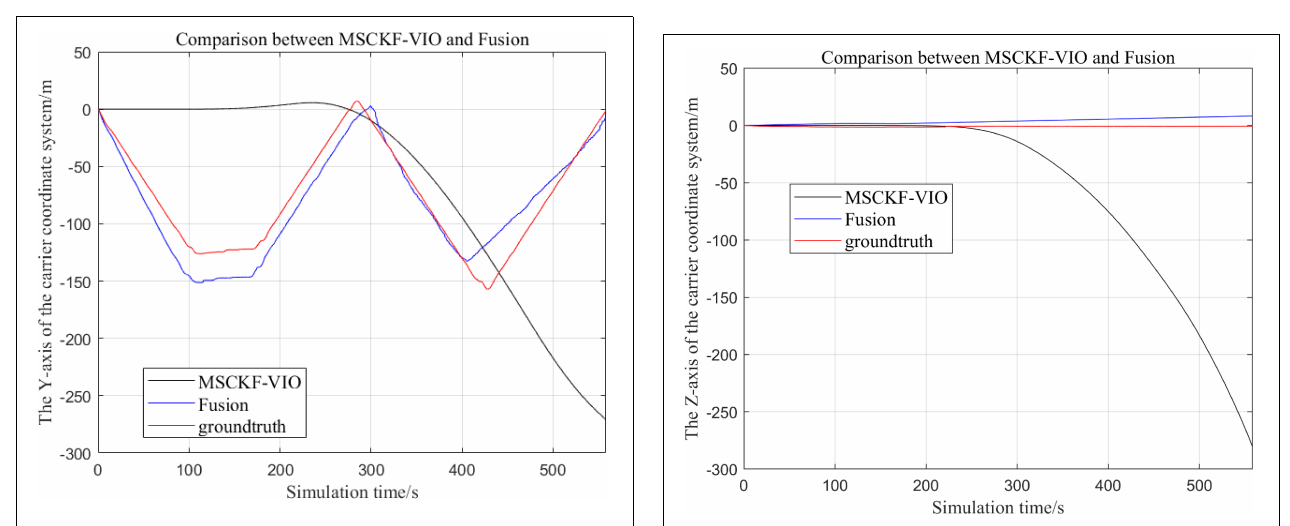
FIGURE 6 | Comparison of the overall trajectory in y -axis between the fusion algorithm and the MSCKF_VIO algorithm.